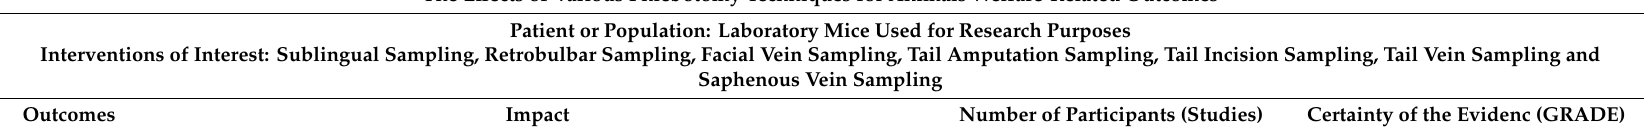
The E ff ects of Various Phlebotomy Techniques for Animals Welfare-Related